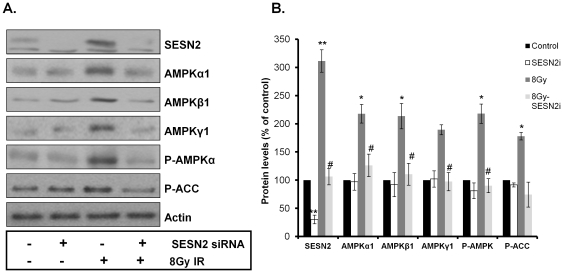
IR-induced expression and activity of AMPK is dependent on SESN2.(A) MCF7 cells were treated with SESN2 siRNA for 48 h prior to being exposed to a single dose of 8Gy IR. The cells were lysed 24 h after IR and western blotting was preformed with the indicated antibodies. A representative immunoblot from 3–4 independent experiments is shown. (B) The results from (A) were quantitated and expressed as the mean and SE from 4 independent experiments (* = P<0.05 compared to control, ** = P<0.01 compared to control, # = P<0.05 compared to 8Gy IR).